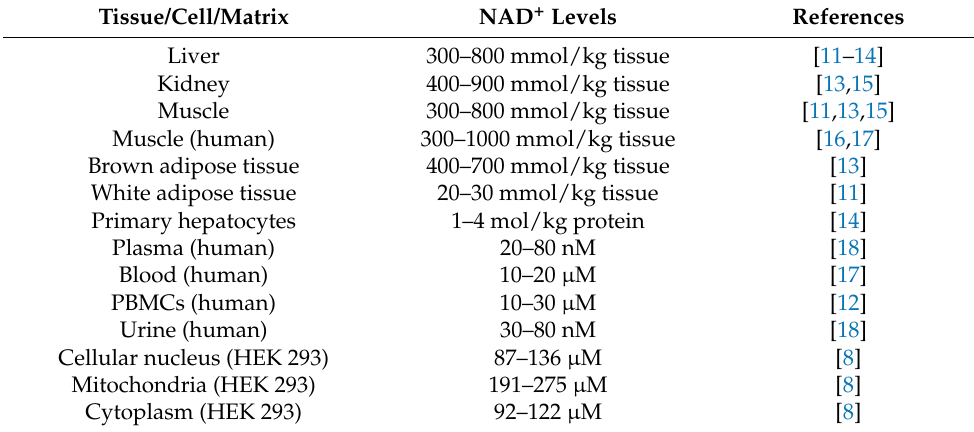
Table 1. Baseline NAD + levels reported for different cells/tissues. Unless otherwise specified, values refer to murine